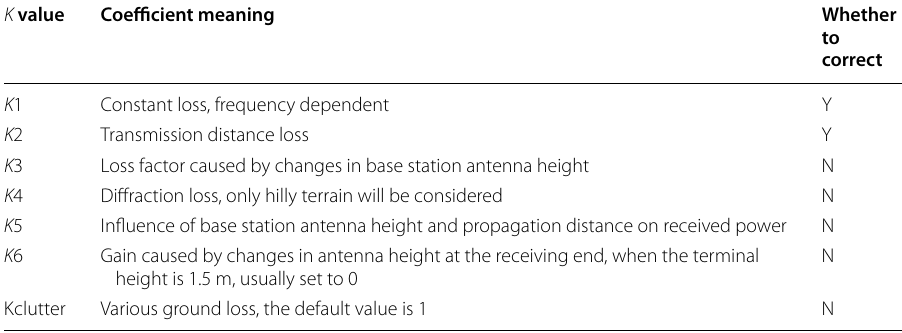
Table 2 K value correction coefficient term of SPM model K